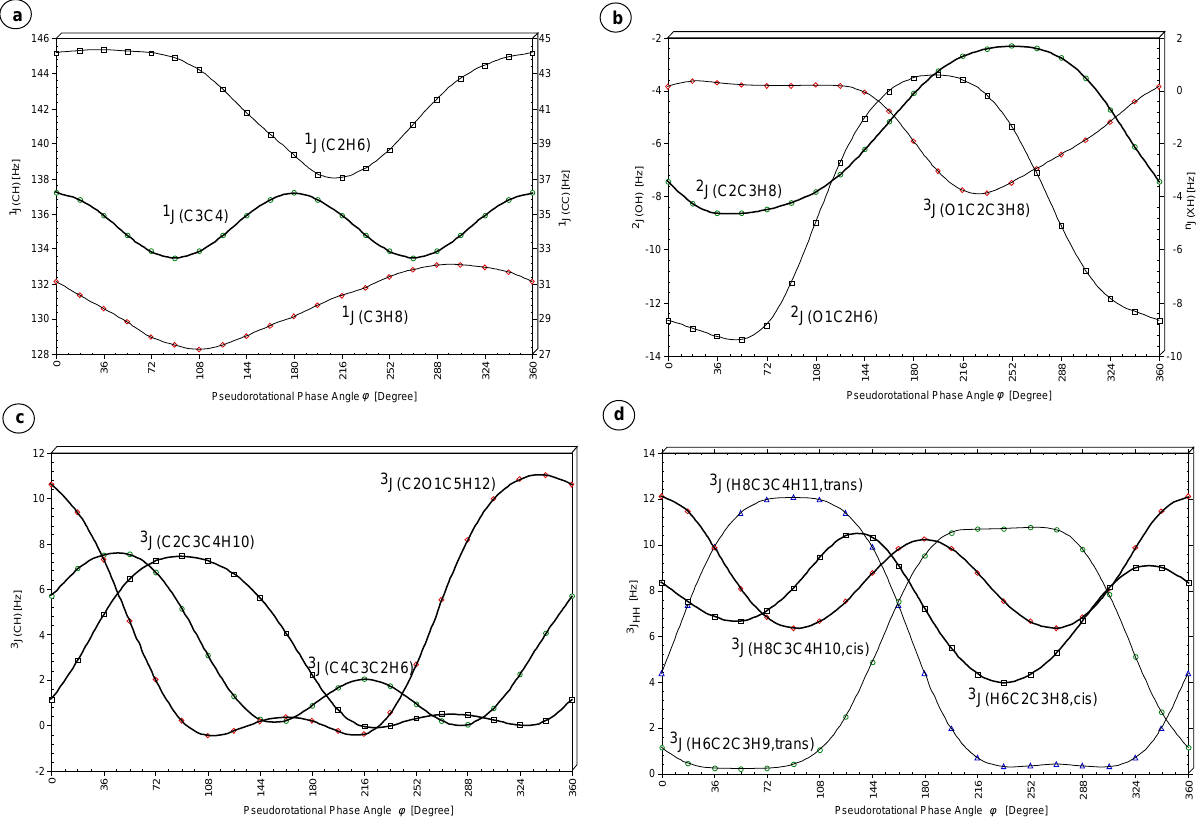
Figure 6: Calculated SSCCs n J as a function of the pseudorotational phase angle φ . (a) One-bond SSCCs 1 J(C2H6), 1 J(C3C4) and 1 J(C3H8). (b) 2 J(O1C2H6), 2 J(C2C3H8) and 3